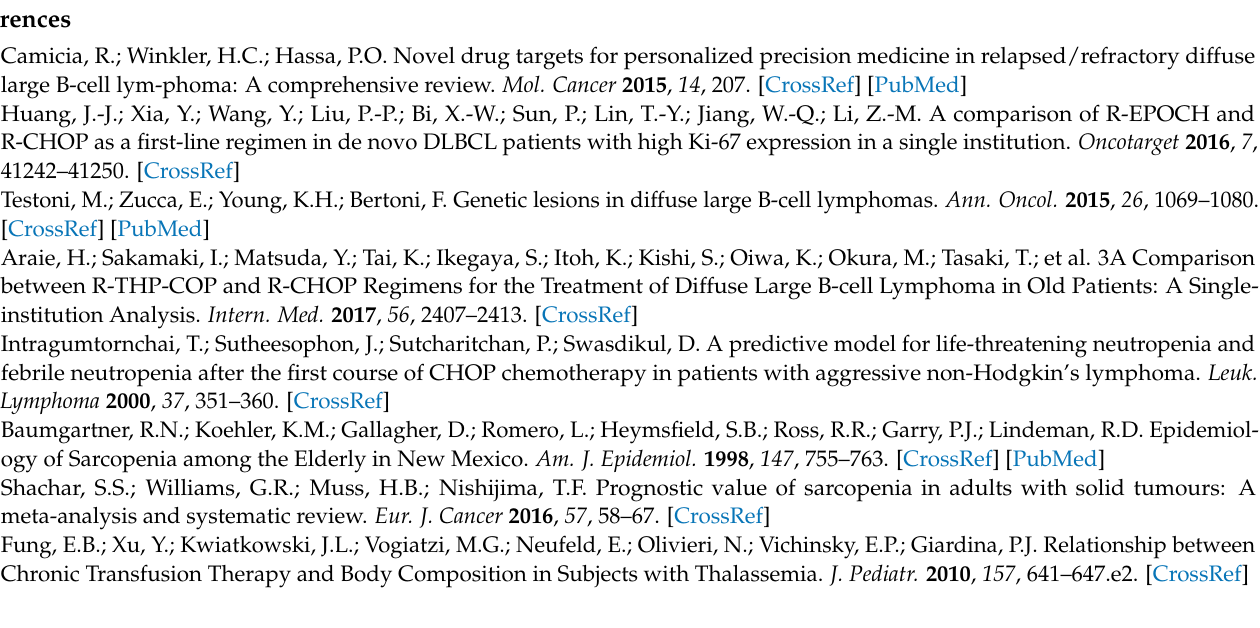
Figure S3: The expression of body composition in different stages. (A) SMG (skeletal muscle gauge), Figure S4: Pearson correlation between BSA (body surface area) and SMG (skeletal muscle